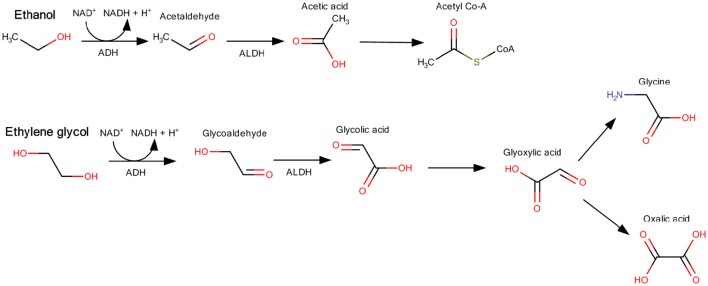
Examples for the different metabolic pathways of alcohols (ethanol) and glycols (ethylene glycol). Ethylene glycol metabolism leads to glyoxylic acid and oxalic acid, which are nephrotoxic, whereas ethanol is metabolized to acetyl Co-A (Figure modified after Kraut and Kurtz, 2008; Schep et al., 2009).